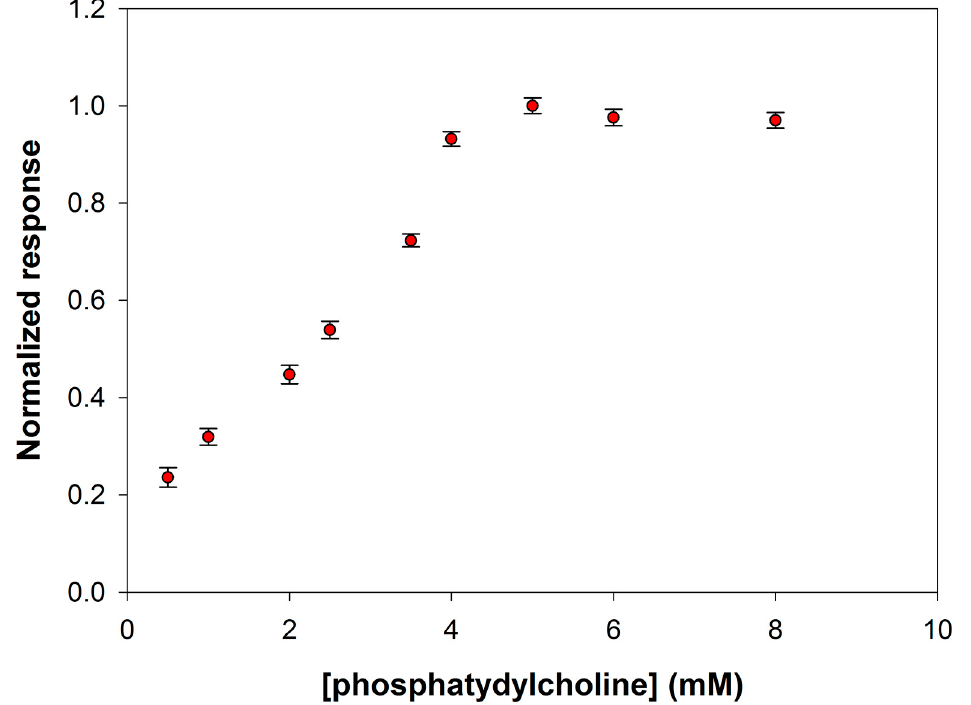
Figure 6. Normalized response (i.e., response/maximum response) of a typical Pt/PPyox/ChO biosensor to PLD 0.22 IU/mL as a function of phosphatidylcholine concentration. Supporting electrolyte: borate buffer pH 8.0, I 0.05 M containing 0.75% (v/v) Triton X-100, and 0.2 mM calcium chloride. Electrode rotation rate: 200 rpm.